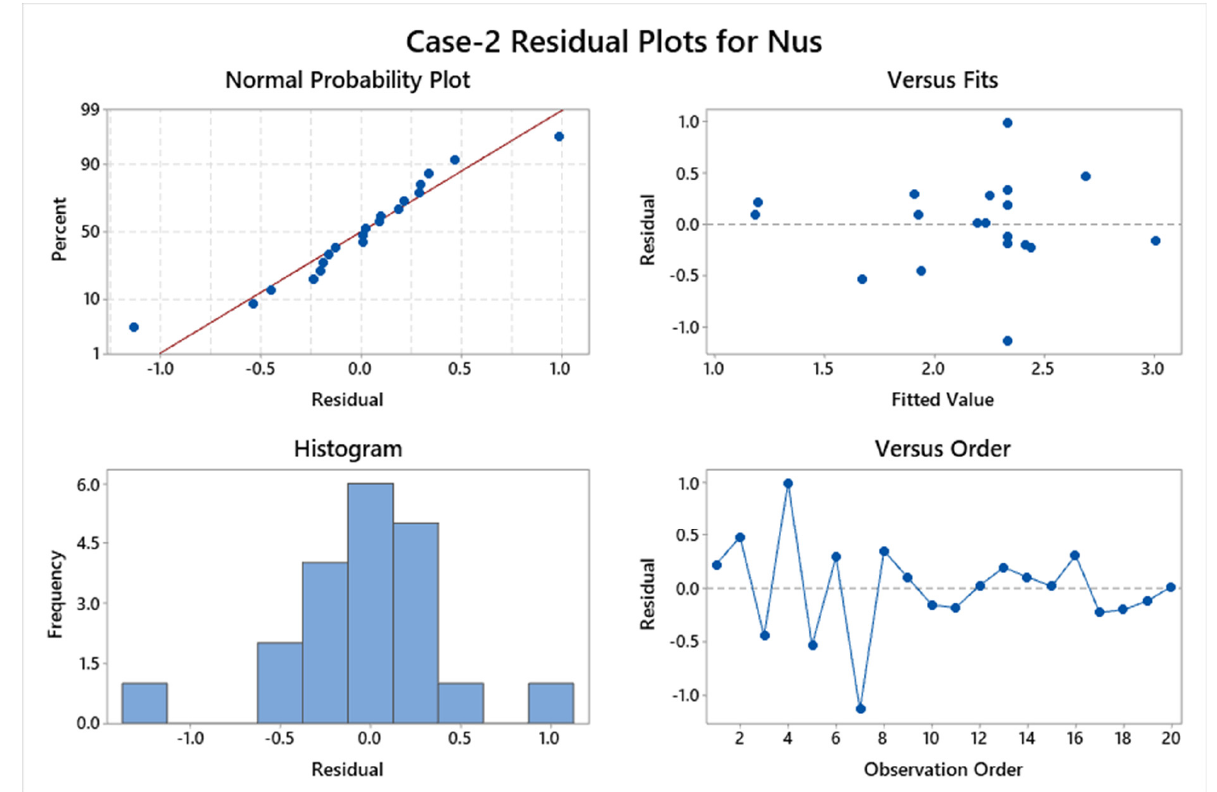
Figure 17. Case-1 Residual plots for Nusselt number.